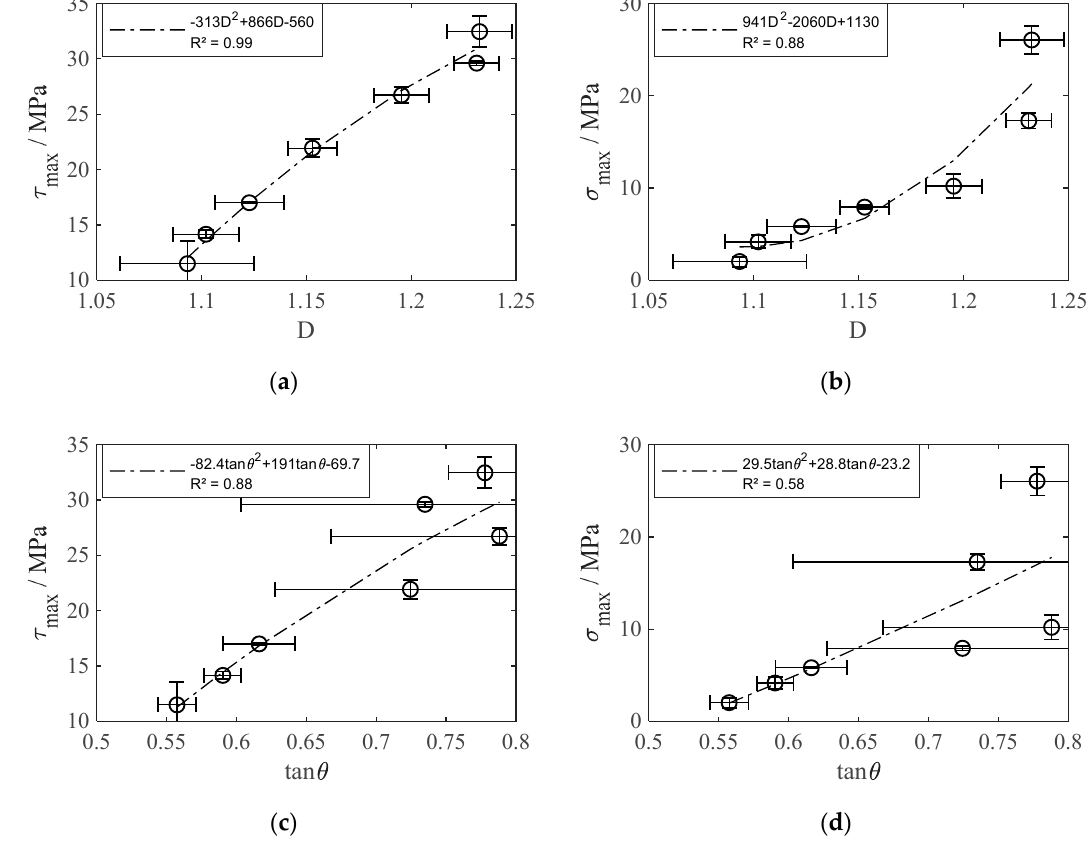
Figure 9. Interlaminar shear and tensile strength in relation to ( a , b ) fractal dimension D and ( c , d ) surface roughness slope tan θ ; mean values ± 1 SD.